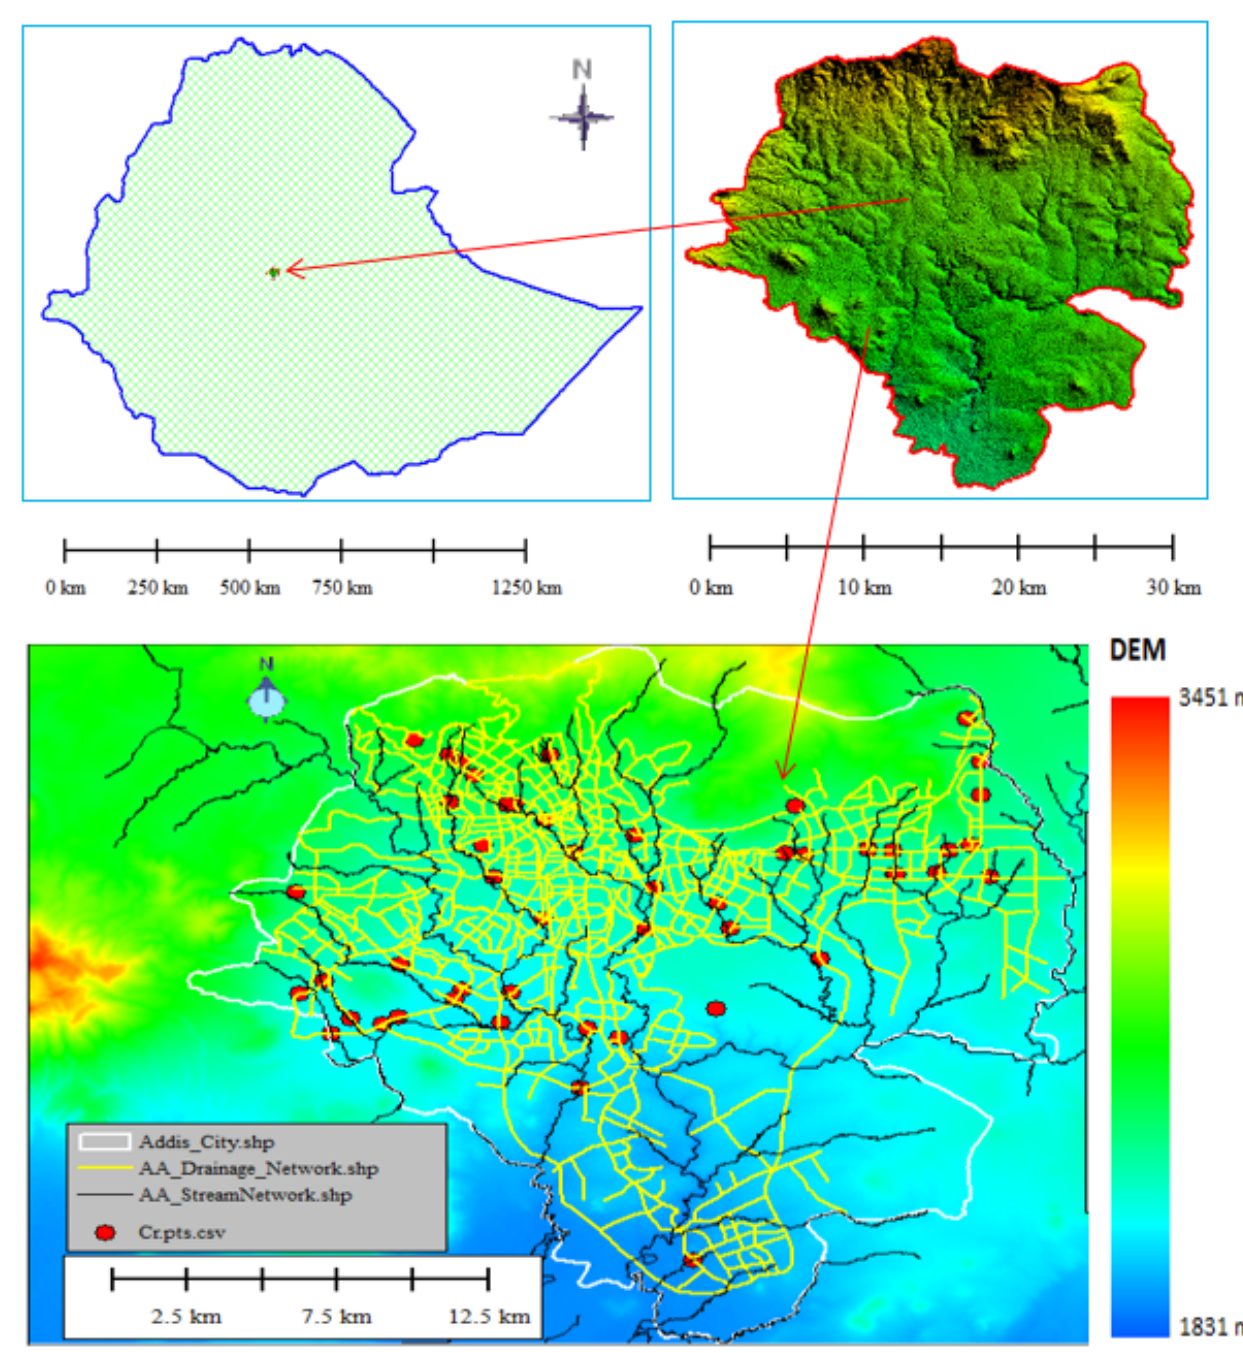
Figure 2. Study Area: Ethiopia (upper left), Addis Ababa City (upper right), and cross- and longitu- dinal drainage systems of the study area (bottom).